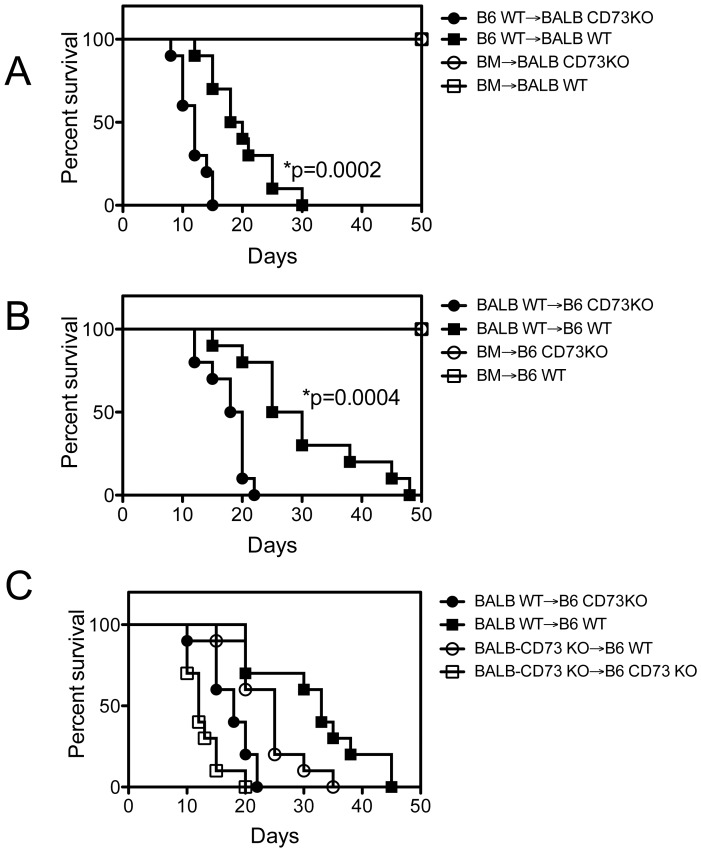
Recipient CD73 limits GVHD development.(A) Lethally irradiated WT (n = 10) or CD73 KO (n = 10) BALB/c mice were given i.v. injections of 5×106 T cell depleted BM cells from B6 mice donors alone (n = 5) or with 2×107 splenocytes from WT B6 donors. Lethally irradiated WT (n = 10) or CD73 KO (n = 10) B6 mice were given i.v. injections of 5×106 T cell depleted BM cells from BALB/c mice donors alone (n = 5) or with 2×107 splenocytes from WT BALB/c donors (B) or CD73 KO BALB/c donors (C). (A,B) P values indicate the differences between WT versus CD73 KO recipients. (C) BALB WT→B6 CD73KO versus BALB CD73KO→B6 CD73KO, p = 0.0103; BALB WT→B6 CD73KO versus BALB CD73KO→B6 WT, p = 0.0029; BALB CD73KO→B6 WT versus BALB CD73KO→B6 CD73KO, p<0.0001; BALB WT→B6 WT versus BALB CD73KO→B6 WT; p = 0.0284. Results are representative of 2 independently performed experiments with similar results.